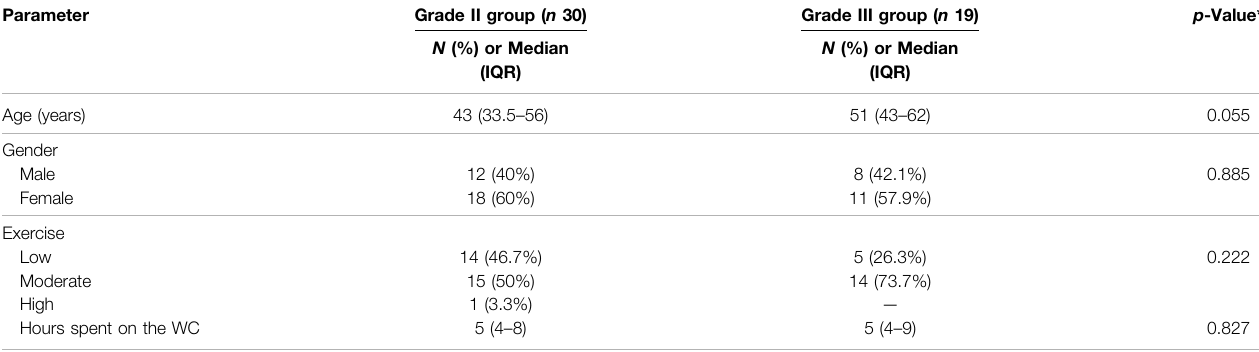
TABLE 1 | Baseline characteristics of selected patients for the study, divided into two groups according to hemorrhoidal grade (grade II and grade III).